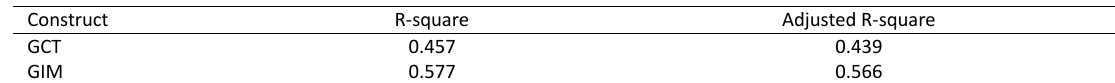
Table 6: R-square (R 2 )